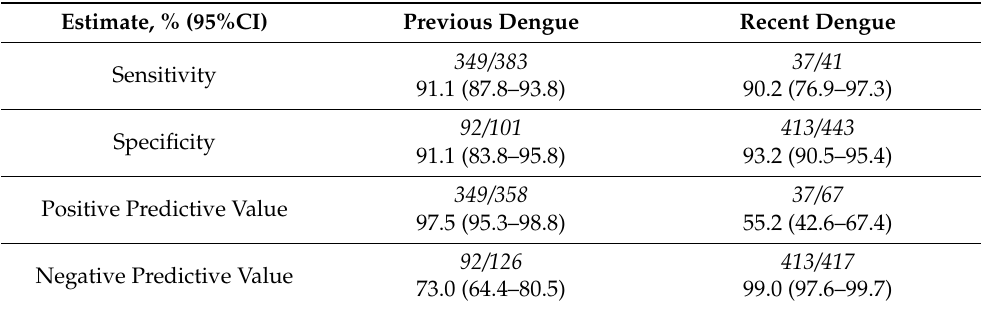
Table 2. Accuracy of ViroTrack Dengue Serostate for the Diagnosis of Previous and Recent